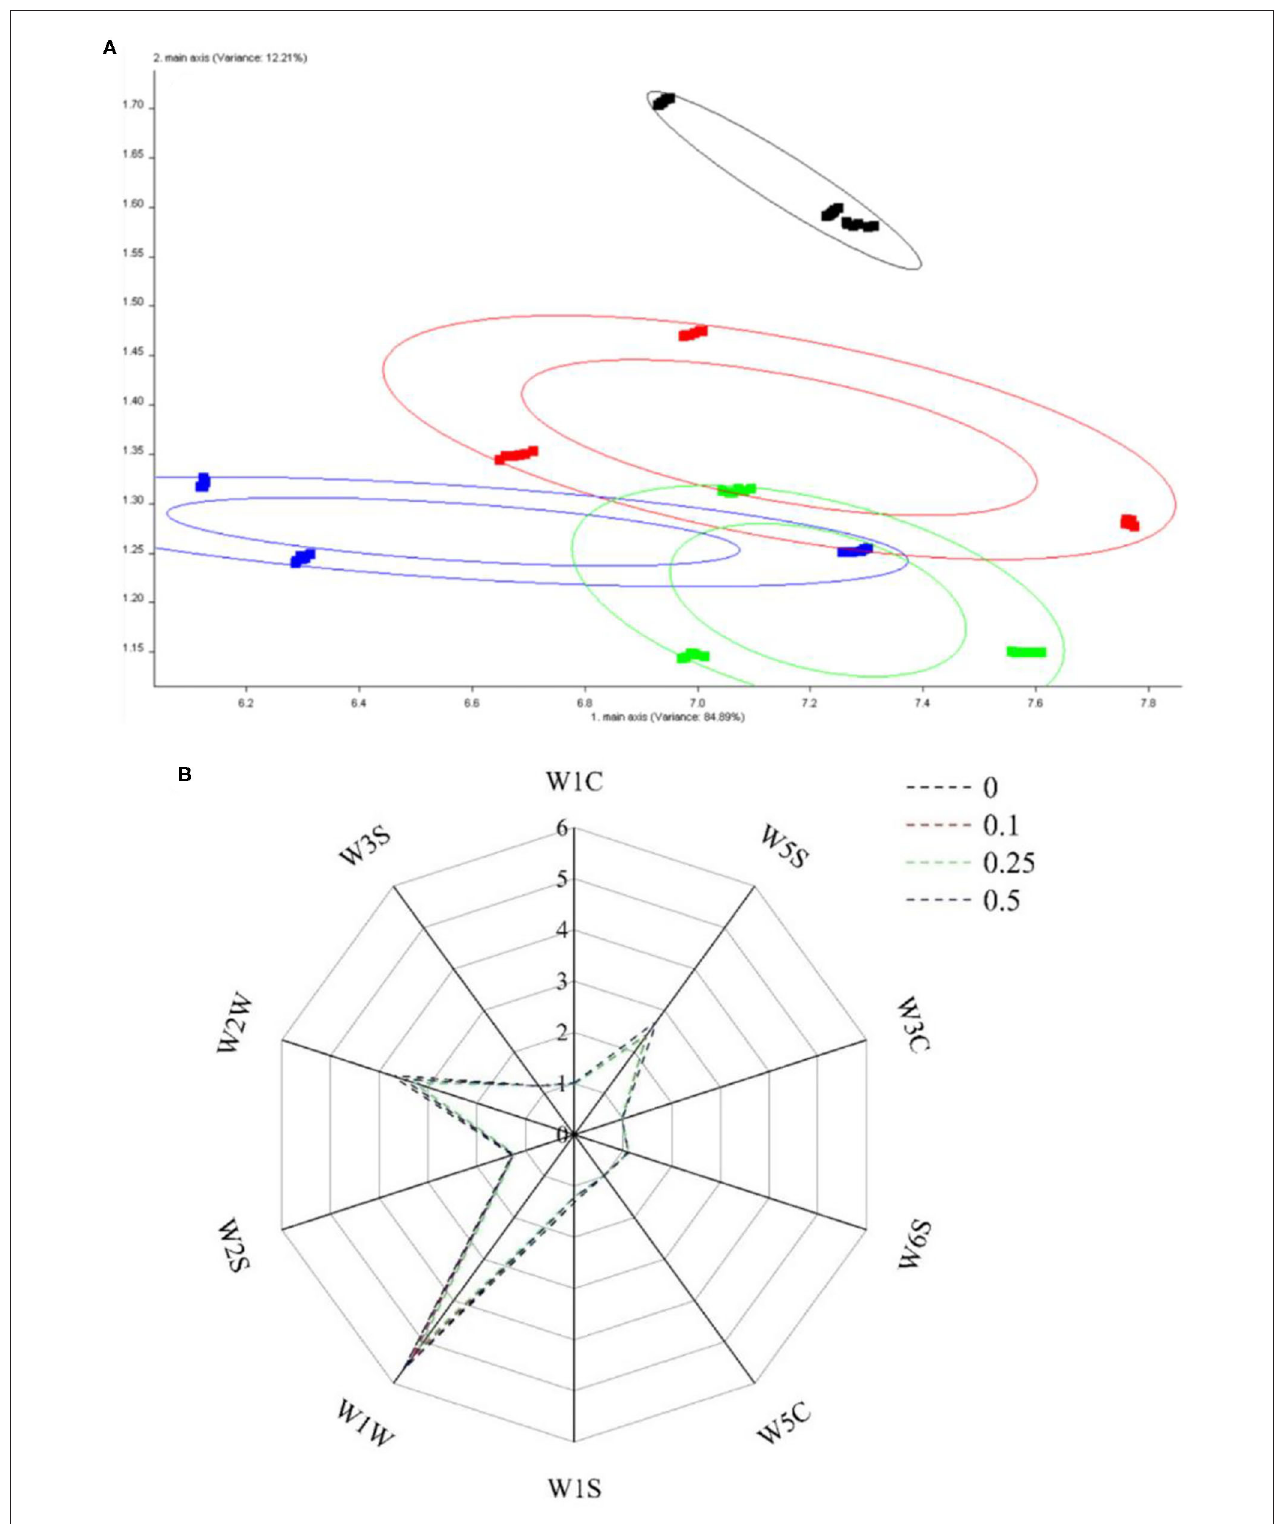
FIGURE 10 | PCA diagram (A) and radar chart (B) of electronic nose.